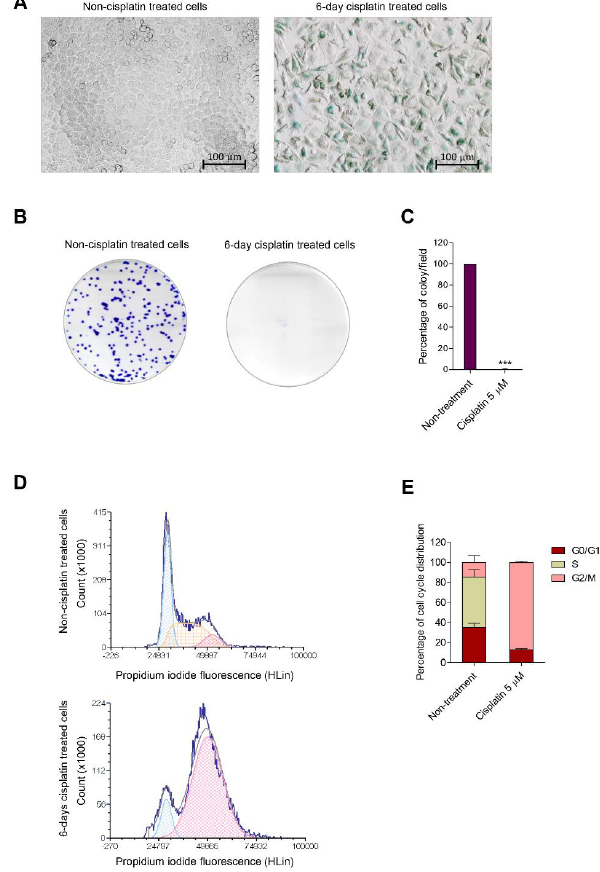
Figure 1. ( A ) The characteristics of H460 senescent cells were evaluated by SA- β -gal staining after continuous treatment with low-dose cisplatin for 6 days compared with the non-treated control. ( B , C ) A colony formation assay was performed to evaluate the proliferating inhibition properties of senescent cells after cisplatin treatment for 6 days. The colonies were cultured for 7 days and stained with crystal violet before capturing the image. The percentage of colonies per field was calculated. ( D ) The DNA content in each cell cycle phase was analyzed by flow cytometry with propidium iodide (PI). The histogram represented cell cycle distribution. ( E ) The percentages of DNA content in each phase are presented in a bar graph. Data represent the mean ± SEM ( n = 3) (*** p < 0.001, compared with the non-treated control).